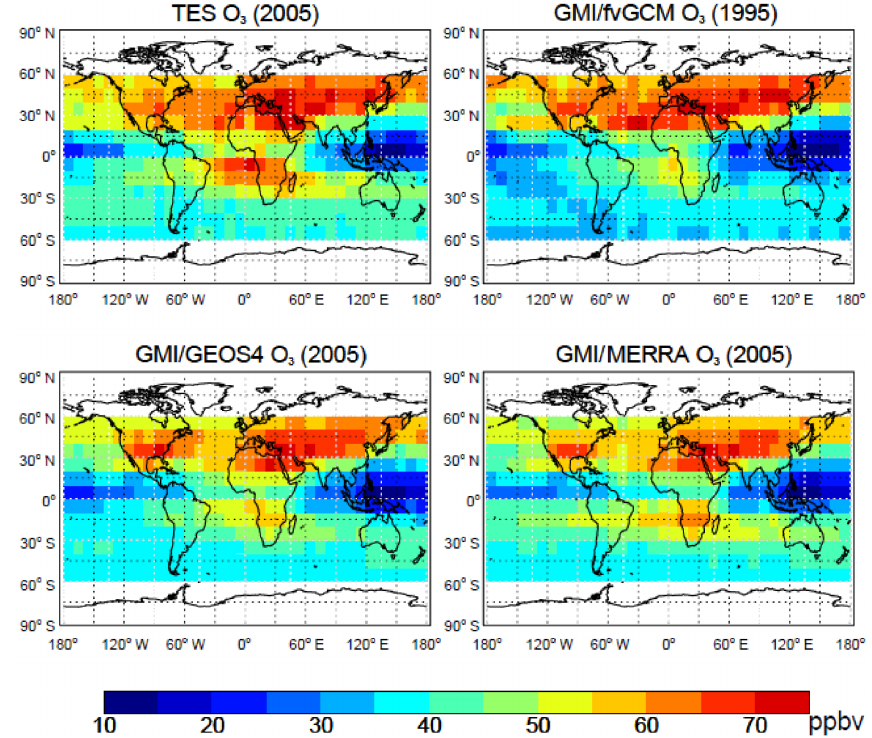
Figure 10. Mean mixing ratios of O 3 at 618hPa observed by TES during July–August 2005 and corresponding GMI CTM results with 3- hourly output sampled along the TES orbit tracks. TES averaging kernels and a priori were applied to the model output. Results are averaged into 10 ◦ × 10 ◦ grid